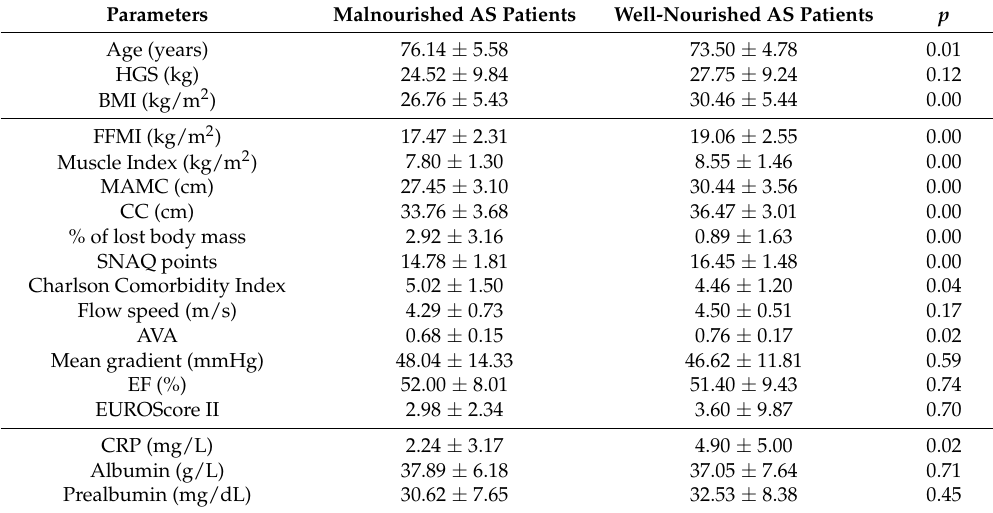
Table 5. The comparison between well-nourished and malnourished patients with AS. Data is presented as mean ± SD.